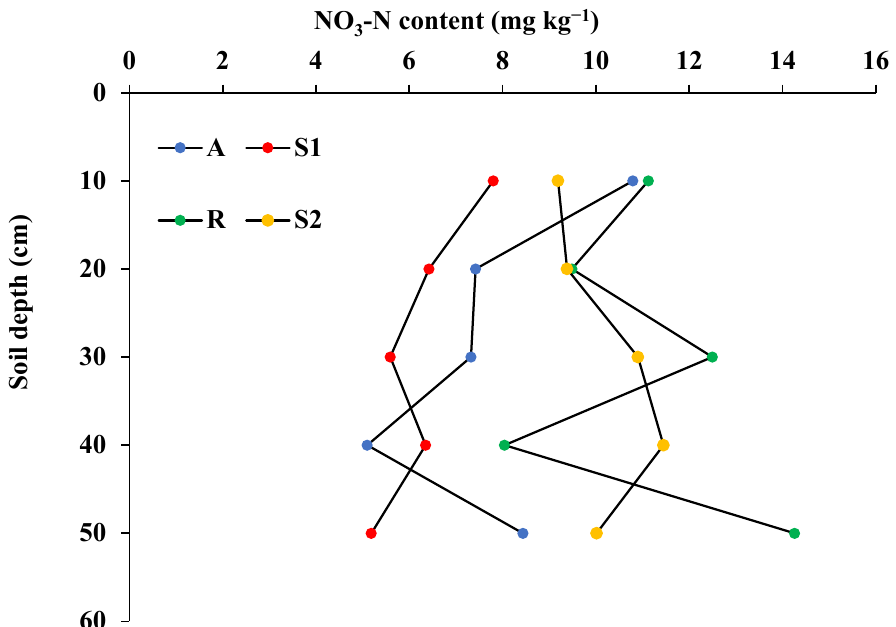
Figure 15. Soil NO 3 -N content at different soil depths under different treatments in two seasons.